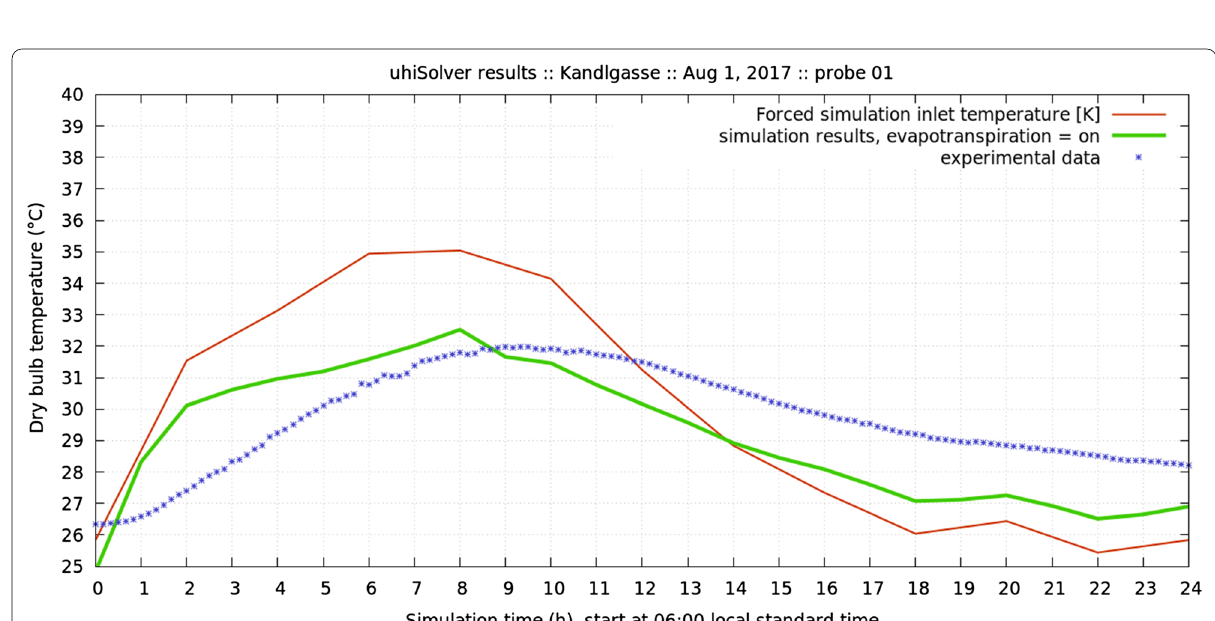
Fig. 13 Comparison of simulation results with evapotranspiration (green line) and measurement data (blue dots) for the validation case Kandlgasse compared to the forced inlet temperature (red